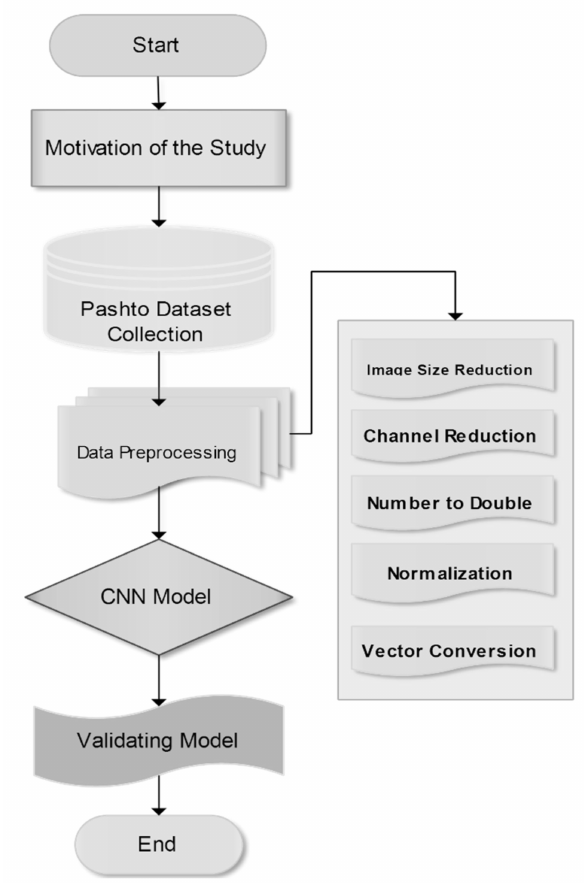
Figure 1. The Proposed Methodology